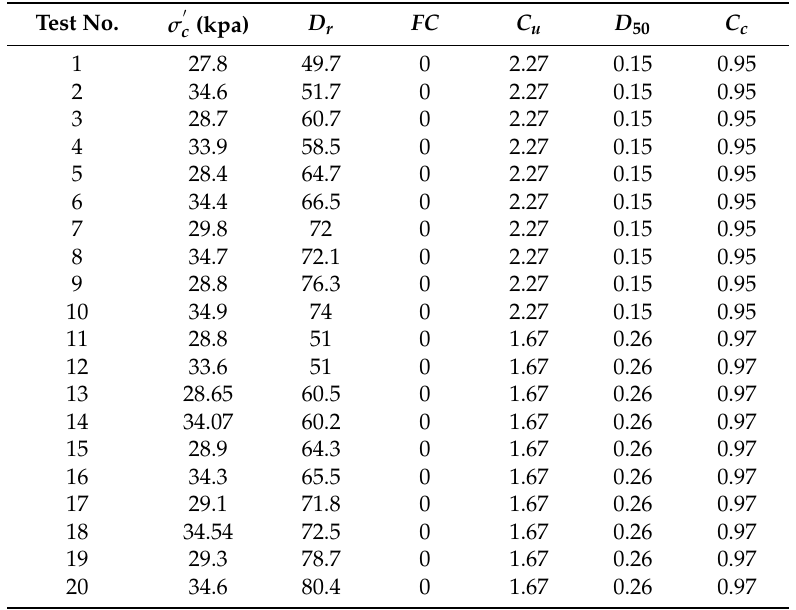
Table 11. The 20 samples from Dief [38] that were used for a comparison of models’ performance. Test